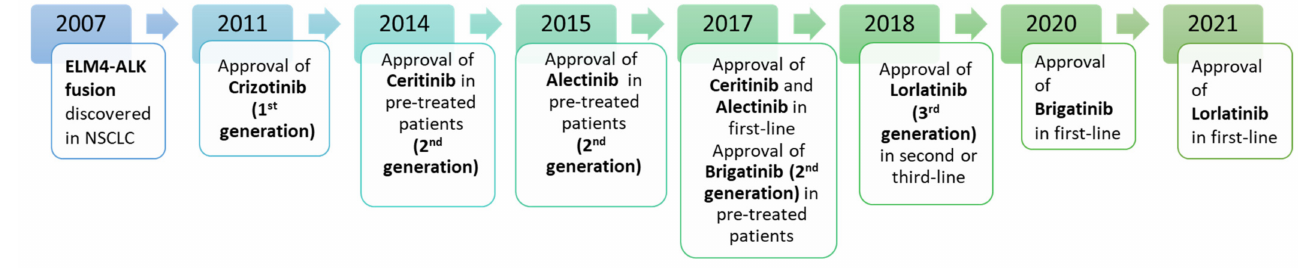
Figure 2. Approval timeline of currently available ALK